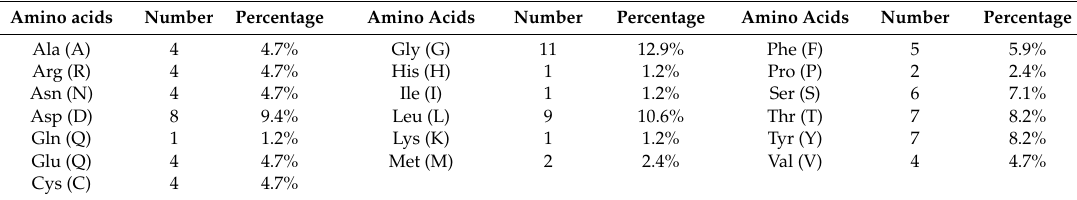
Table 1. Amino acid composition of Bx-tlp-2.